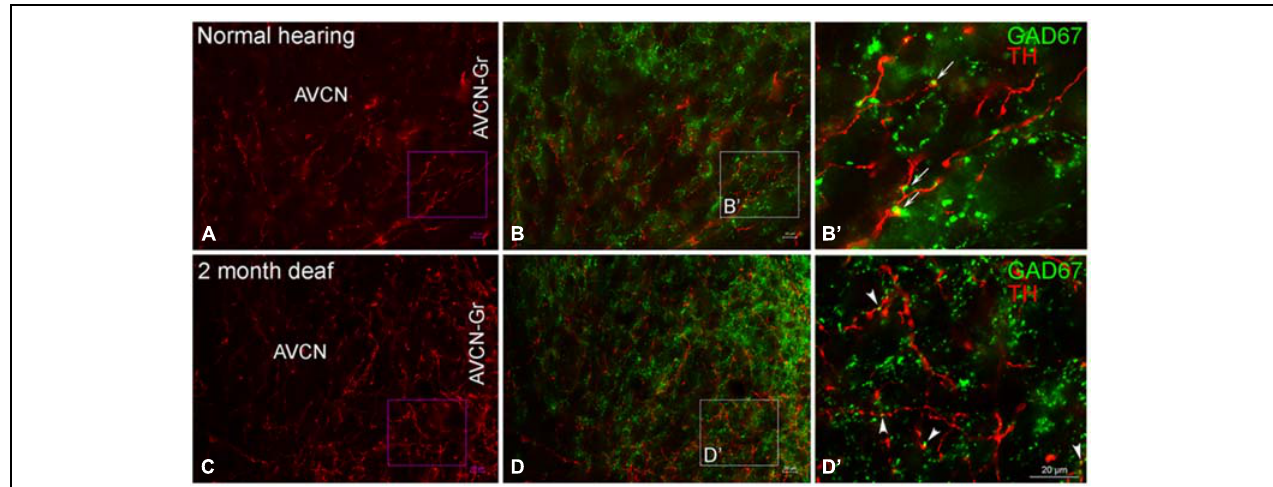
FIGURE 5 | In the AVCN the majority of GAD67 (green) has a distribution that is distinct from TH (red). While GAD67 is primarily localized to organized axosomatic GABAergic terminals (B,B’) , TH on the other hand, appears to be localized both to dendrites and axon terminals (A,C) . Two months after